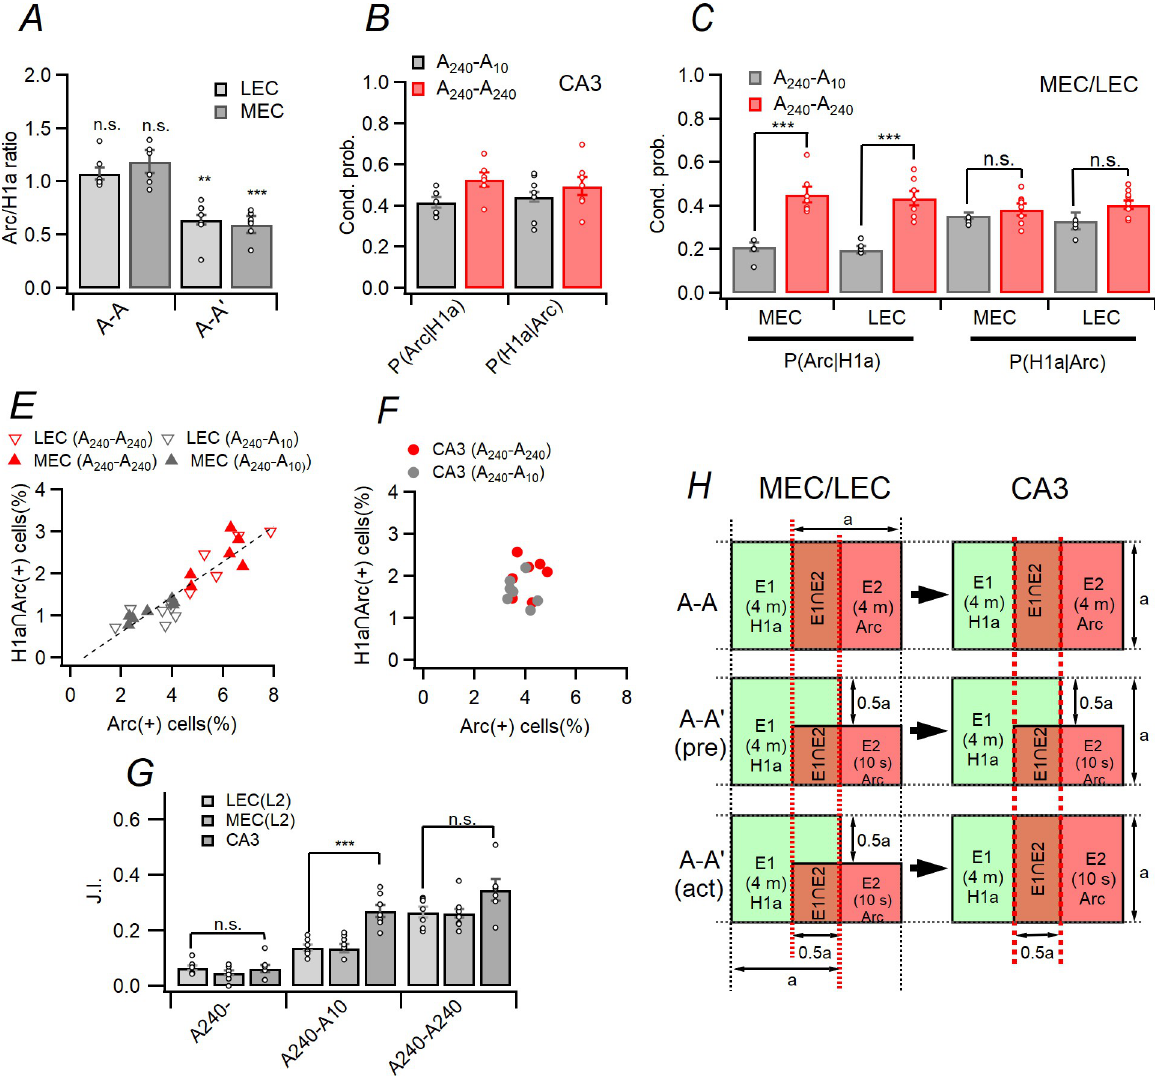
Fig 4. Analysis of ensembles for hippocampal CA3 and LEC/MEC region. (A) Ratio between Arc (+)/ H1a (+) cells in MEC/LEC. This figure suggests that size of Arc (+) ensembles is about half of H1a (+) ensemble size for the cohort A 240 -A 10 . (B) Conditional probability, i.e. P( Arc | H1a ) and P( H1a | Arc ), in CA3. (C) The P( Arc | H1a ) and P( H1a | Arc ) in MEC/LEC (prob: F (1,24) = 8.413, p = 0.008; cohort: F (1,24) = 32.752, p < 0.001; region: F (1,24) = 0.008, p = 0.929; cohort × prob × region: F (1,24) = 3.576, p = 0.071; GLM). Because the size of the Arc (+) and H1a \ Arc (+) ensembles and was smaller than that of the H1a (+) ensembles, the values of P( Arc | H1a ) are smaller in the cohort A 240 -A 10 than in cohort A 240 - A 240 . (D) The linear relationship between the size of Arc (+) ensembles and H1a \ Arc( +) ensembles for LEC/MEC. Note that relationship between two variables are well fitted to linear function. (E) The relationship between the size of Arc (+) ensembles and H1a \ Arc (+) ensembles for the CA3. In the case of CA3, the size of the Arc (+) ensemble and H1a \ Arc (+) are distributed within a certain range regardless of the type of cohort. (F) J . I . between Arc (+) and H1a (+) ensembles in CA3 and MEC/LEC. Note that the J . I . on CA3 ensembles for A 240 -A 10 cohort is much higher than that on MEC/LEC ensembles (region: F (2,27) = 25.223, p < 0.001; cohort: F (2,27) = 114.082, p < 0.001; cohort × region: F (4,27) = 12.957, p < 0.001; GLM). (G) Schematic diagram of LEC/MEC and CA3 response evoked in A 240 -A 240 ( upper ) and A 240 -A 10 cohort ( middle and lower ). The middle row depicts that predicted CA3 responses ( right ) based on MEC/LEC activity ( left ) whereas the bottom low depicts that actual CA3 responses ( right ) based on MEC/LEC activity ( left ) which is evoked by novel exposure. Dotted red lines and their corresponding values indicate relative size of ensembles such as P( H1a \ Arc ) for each cohorts and situations.